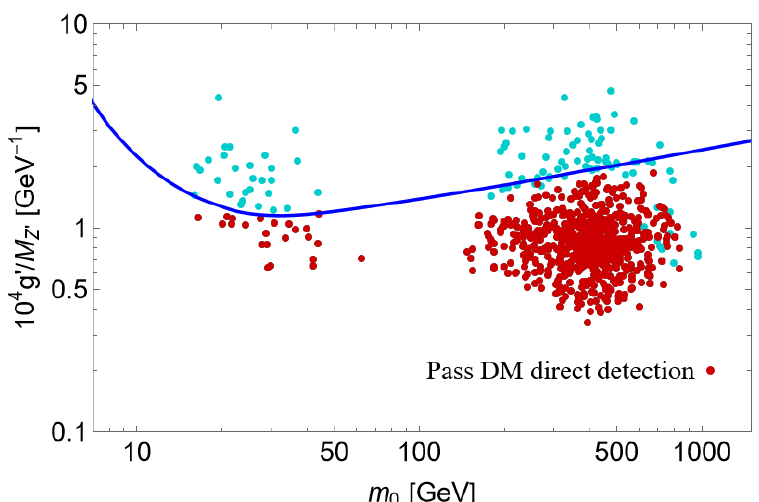
Figure 8. Benchmark points producing the observed BAU, relic abundance on the plane of the combined dark gauge parameter ratio 10 4 g 0 /M vs the dark fermion mass parameter m . Red Z 0 0 points satisfy dark matter direct detection constraints, while cyan points do not. The dark gauge parameters g 0 and M are calculated to give the observed baryon asymmetry, which is proportional Z 0 to ∼ g 0 2 /M 2 . The Z 0 exchange channel dominates the direct detection cross section in most of Z 0 the parameter space except for the region where m is heavy and g 0 /M is small. The bound for 0 Z 0 g 0 /M Z 0 (blue line) is derived from the Z 0 exchange channel cross section, which is proportional to at the low energy limit. This bound weakens as the dark matter mass increases, since the g 0 4 /M 4 Z 0 direct detection constraint is weaker for heavier dark matter.